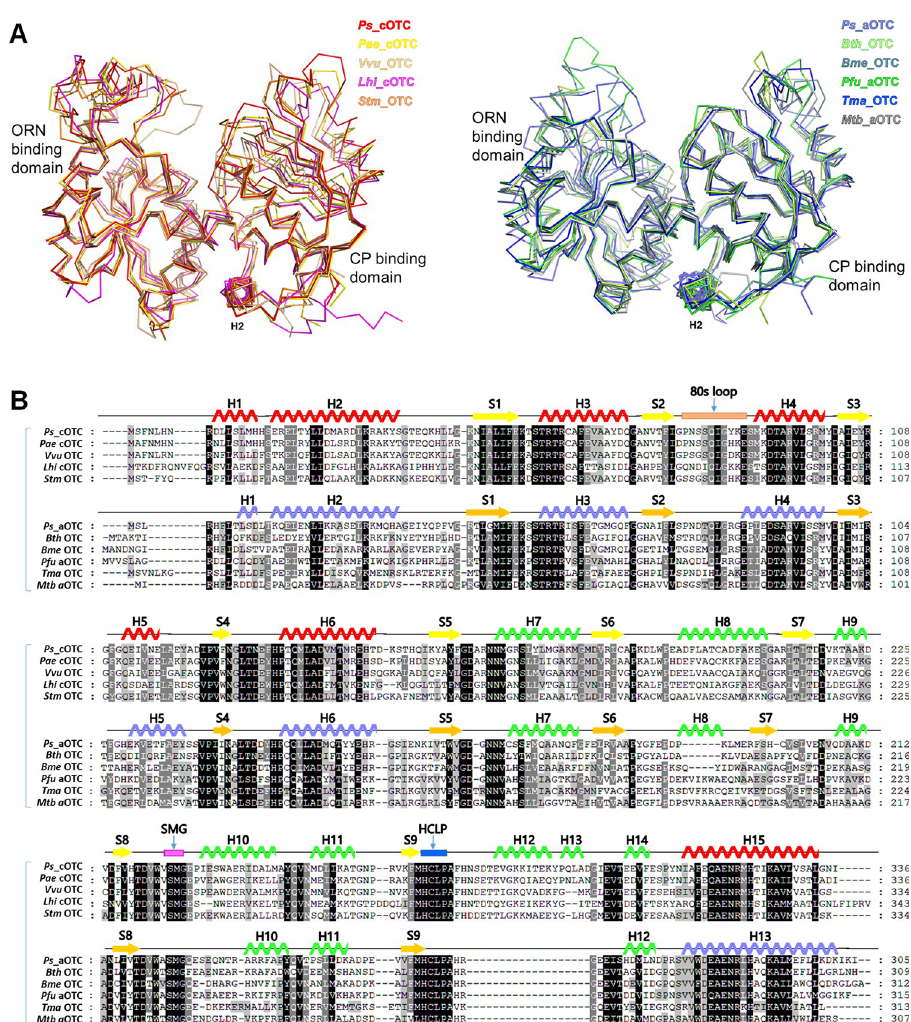
Fig 4. Structural comparison and multiple sequence alignment of Ps _cOTC and Ps _aOTC with orthologues. (A) Least-squares superposition of OTCs with Ps _cOTC and Ps_aOTC. Ribbon representation with different color code was applied for each protein. (B) Multiple sequence alignment of Ps_ cOTC and Ps_ aOTC with their orthologs. The alignment was generated using Clustal X [24]. After alignment, the two groups were separated, and secondary structure elements are shown with reference to Ps_ cOTC and Ps_ aOTC on the top of the alignment. Conservation of residues of 100%, 80%, and 60% are colored black, grey, and white, respectively. The organism abbreviations are defined as: Pae , Pseudomonas aeruginosa ; Vvu , Vibrio vulnificus ; Lhi , Lentilactobacillus hilgardii ; Stm , Salmonella typhimurium ; Bth , Burkholderia thailandensis ; Bme , Brucella melitensis ; Pfu , Pyrococcus furiosus ; Tma , Thermotoga maritima; Mtb , Mycobacterium tuberculosis